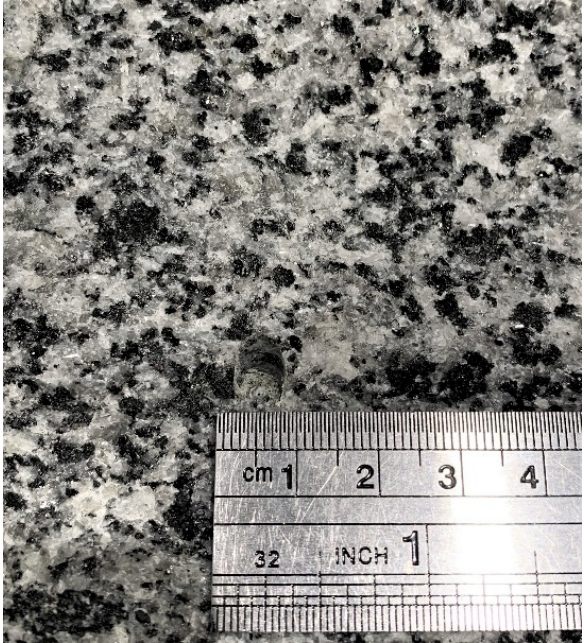
Figure 2. Cross-section of Pokostovsky granite.